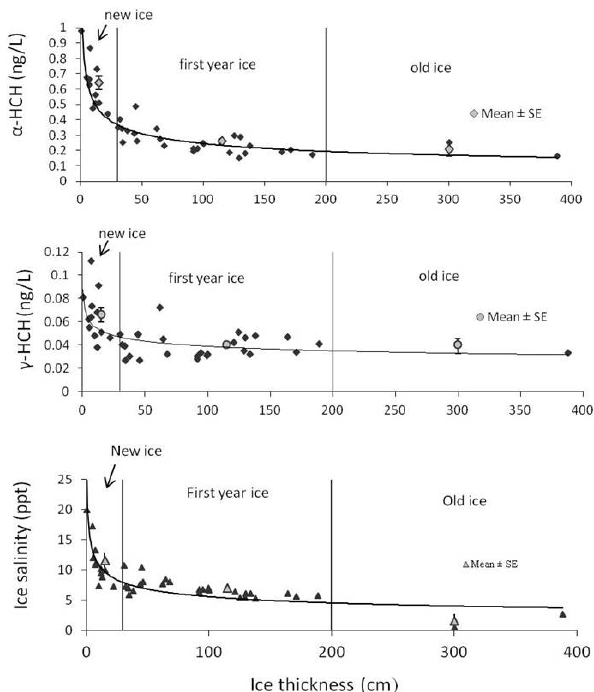
Fig. 6. Dependence of α -HCH (top) and γ -HCH (middle) concen- trations and ice salinity (bottom) on sea ice thickness (adapted from Pu´cko et al., 2010a). Both HCH isomers decreased exponentially with increasing sea ice thickness following the sea ice desalina- tion curve. The correlations observed between HCH concentrations, salinity and ice thickness imply that brine rejection is also accom- panied by HCH